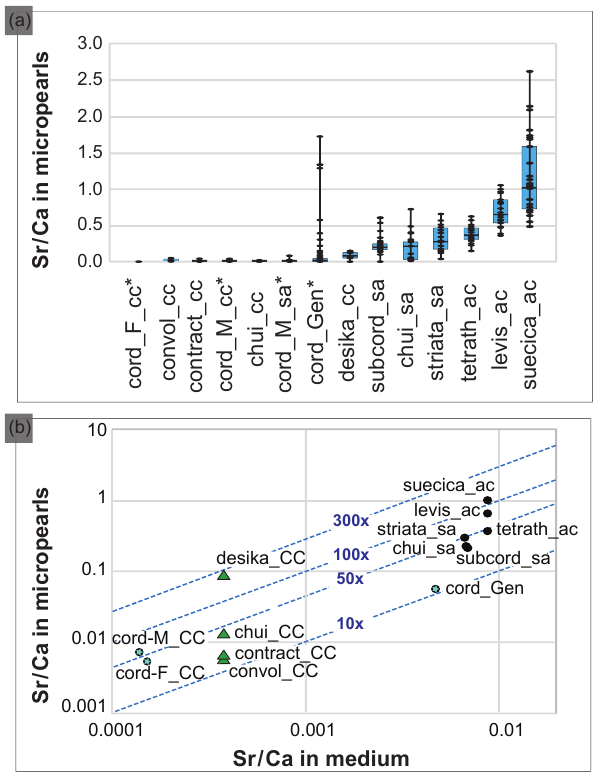
Figure 4. Composition of the Tetraselmis micropearls and their re- lation with the growth media composition. (a) Distribution of the Sr / Ca ratio for each Tetraselmis strain (EDXS analyses), ranked according to the median value of Sr / Ca. At least 20 SEM–EDXS analyses were performed on micropearls of each strain. Asterisks highlight freshwater strains. The range between the minimum and maximum data is shown by black lines. The blue boxes represent the 25–75% inter-quartiles, while the black horizontal line in the boxes shows the median value. (b) Relationship between the com- position of the growth media and the composition of the Tetraselmis micropearls, expressed as the Sr / Ca ratio. Each point represents the median Sr / Ca ratio measured in each species’ micropearls, related to the Sr / Ca ratio of the growth medium. Points with blue stars highlight freshwater strains. The blue dotted lines define the values of the Sr enrichment factor of the micropearls with respect to the medium (10 × , 50 × , etc.). Calcium concentrations of the growth media were calculated, based on media theoretical composition. Green triangles signal four samples grown in the same medium. The abbreviations and characteristics of each strain are indicated in Table 1 while Sr / Ca values appear in Table S2 (for medium) and S3 (for micropearls). Results from T. cordiformis from Lake Geneva (cord_Gen) (Martignier et al., 2017) are given as a comparison.